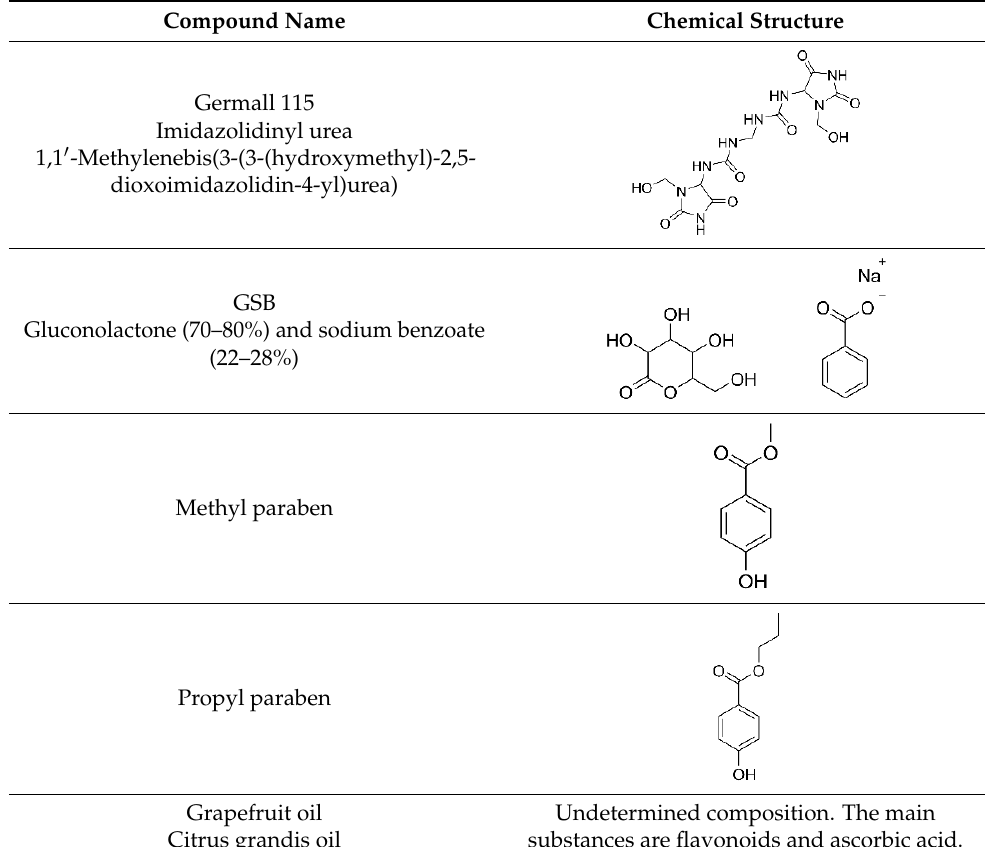
Table 1. Cont. Compound